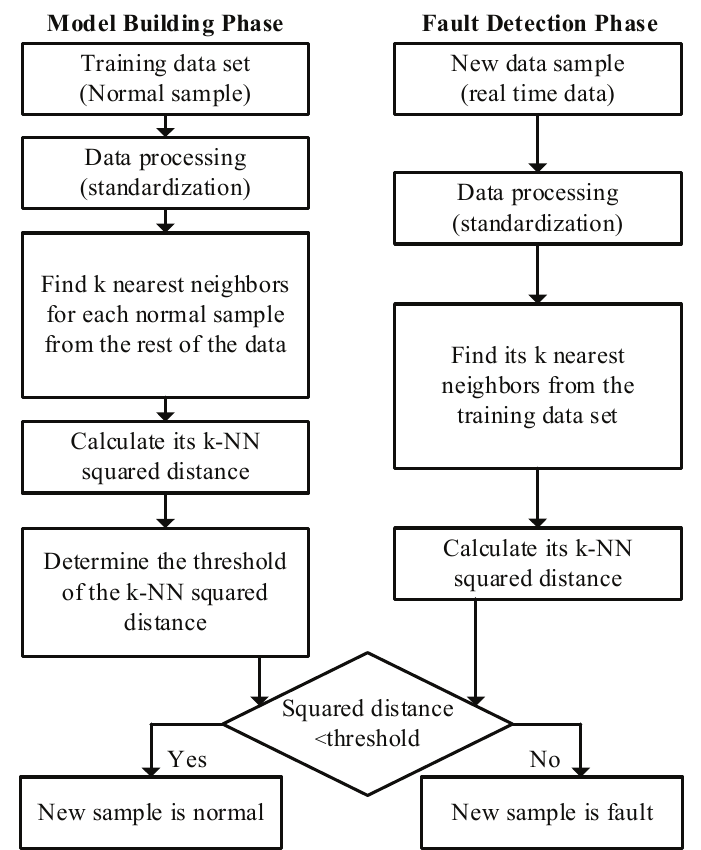
Figure 1. Flowchart of the FD-k-NN